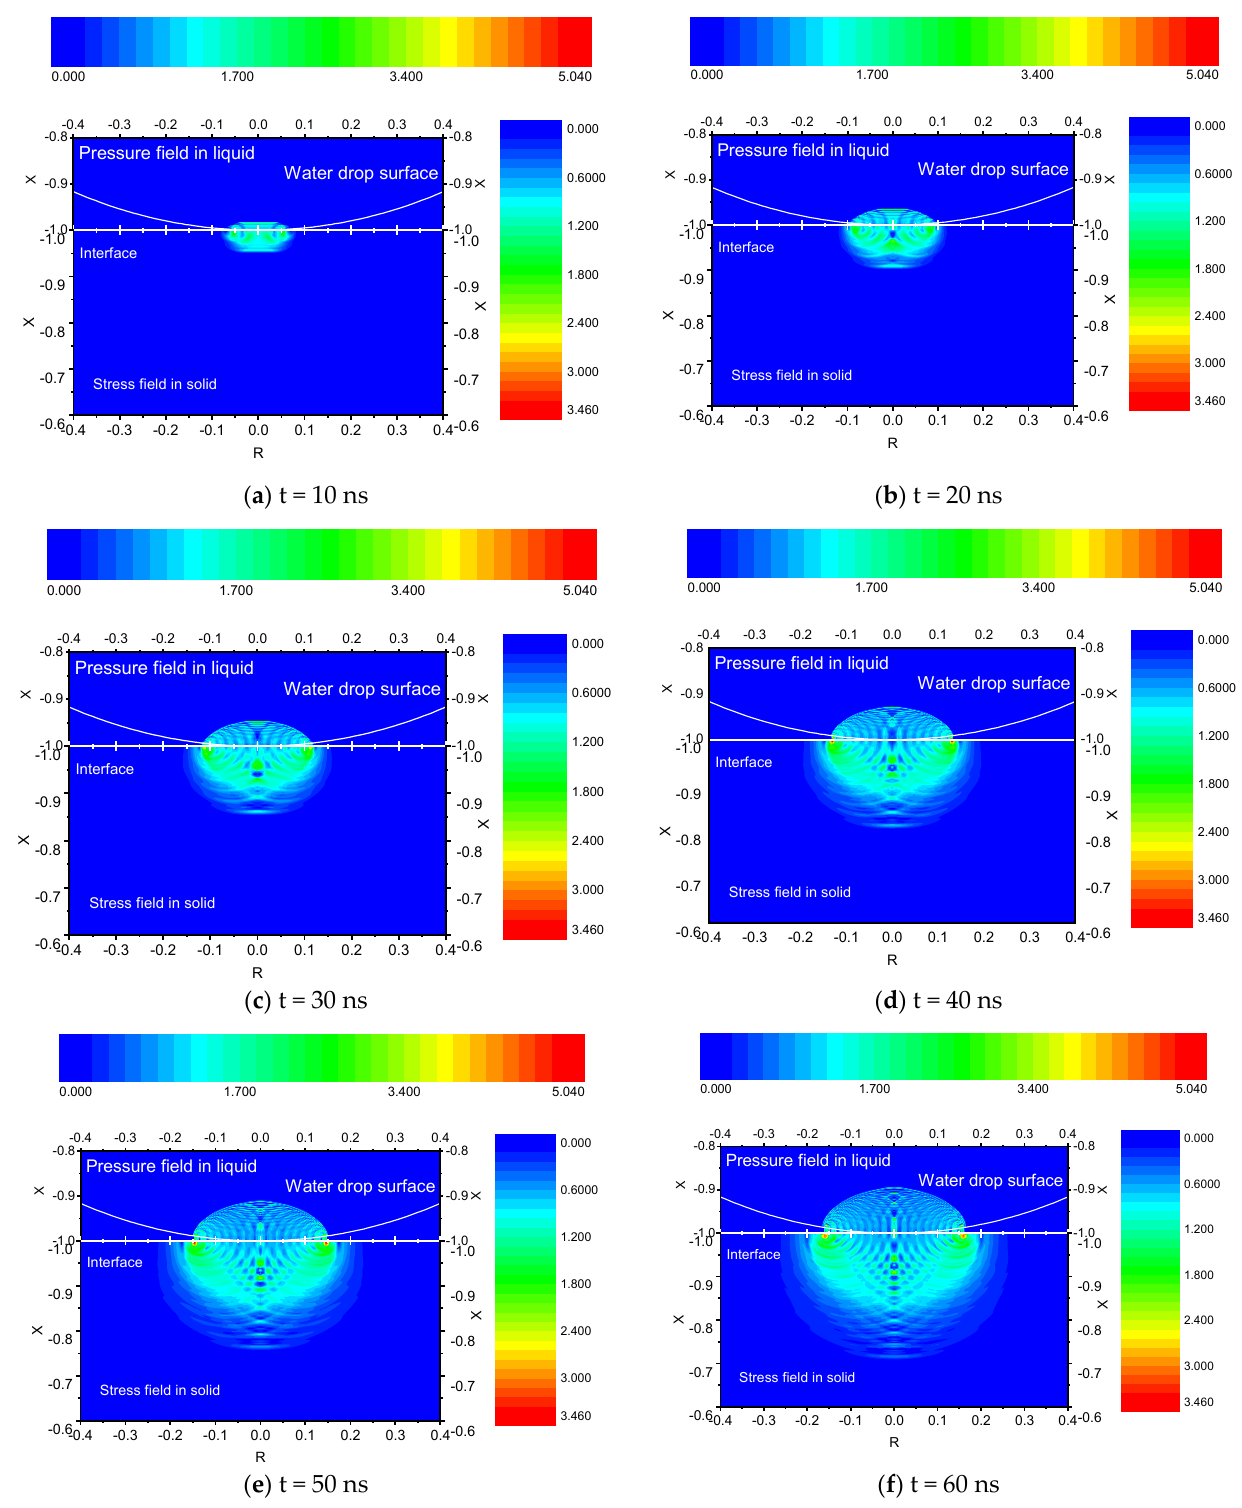
Figure 2. Cloud map of pressure distribution in droplets and stress distribution in scales at different layers (droplet radius r 0 = 1 mm; impact velocity v 0 = 210 m/s; the unit of x and R in the figure is mm).